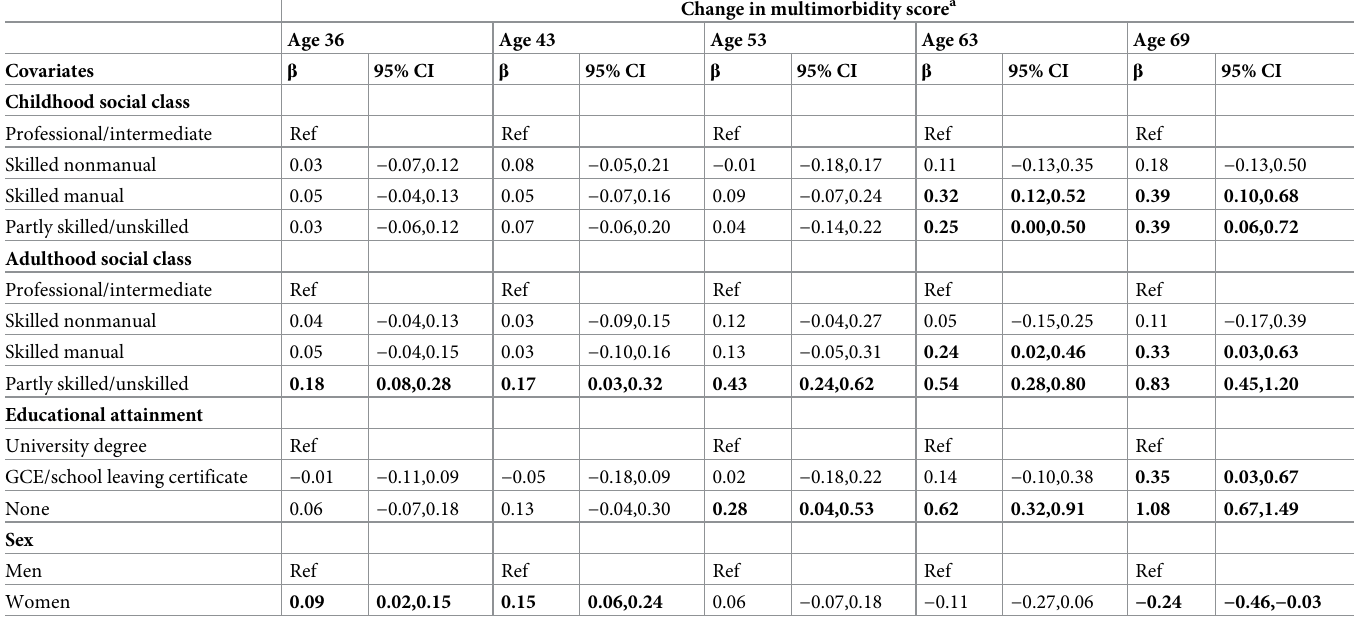
Table 2. Results from linear regression modelling assessing associations between SEP and multimorbidity (unweighted sum of the number of health conditions) in 3,723 participants from the 1946 MRC